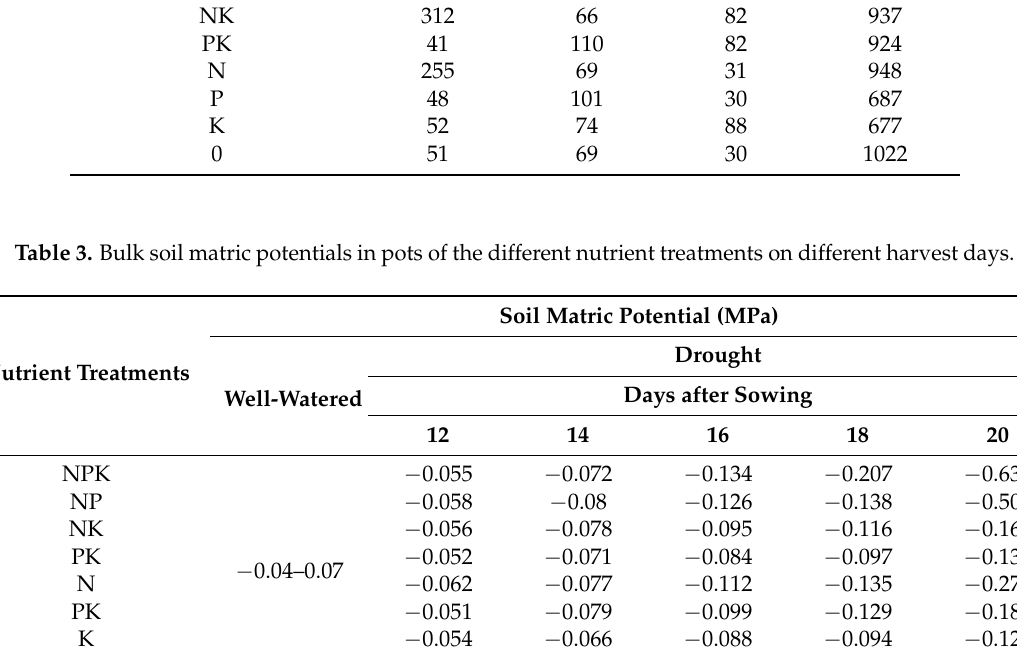
Table 2. Composition of the different levels of the NPK nutrients based on an EDTA extraction for the well-watered and drought treatments. Composition of Nutrients (mg kg − 1 soil) Nutrient Treatments